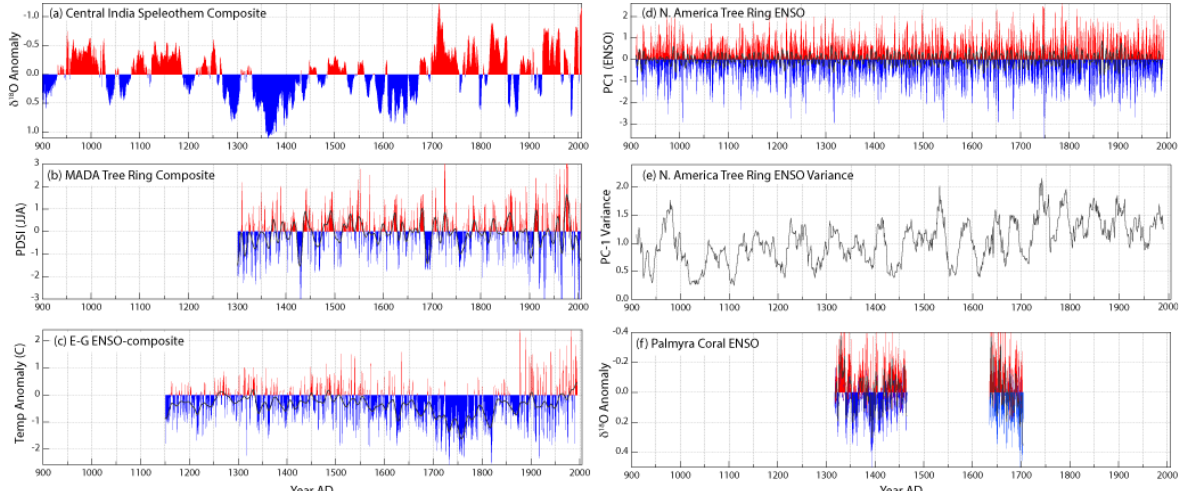
Fig. 3. (a) Annually interpolated speleothem monsoon reconstruction from Fig. 1 shown as isotopic ( δ 18 O) anomalies relative to the mean of the time series. Y axis is reversed so that dry periods point down. (b) The central Indian monsoon reconstruction based on the average of all grid points in central India from the MADA database (Cook et al., 2010). A Lanczos filter is applied to the data to accentuate variability in the 5–15yr window. (c) Niño3.4 SST anomalies from the multi-proxy composite of Emile-Geay et al. (2013). The reconstruction uses the ERSSTv3 instrumental data to train the proxies. (d) The first principal component of the NADA network from Li et al. (2011), which largely reflects SSTs in the eastern tropical Pacific. A similar band-pass filter is applied to the data as in (b) . (e) The bi-weight variance of the PC-1 of the NADA ENSO reconstruction (Li et al., 2011). (f) Two long continuous sections of the Palmyra coral δ 18 O time series from Cobb et al. (2003). As in (a) , the y axs is reversed so that warm SSTs are